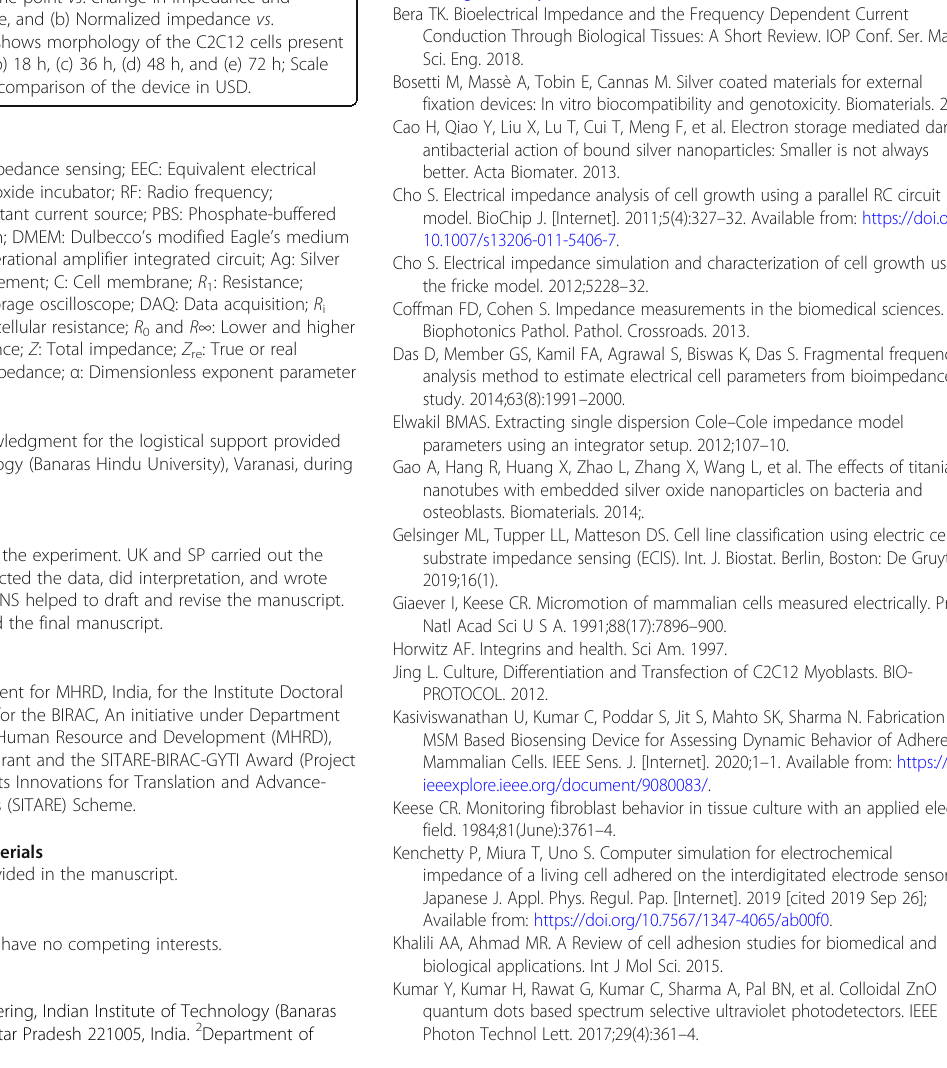
Additional file 1: Figure S1. Calibration graph using different R 1 values. Figure S2. shows the experimental data and its fitting. Figure S3. shows the flowchart for calculating the impedance; (a) Transmitting end, and (b) Receiving end. Figure S4. shows the rate of proliferation with respect to impedance (a) Time point vs . change in impedance and average cell count per image, and (b) Normalized impedance vs . frequency plot. Figure S5. shows morphology of the C2C12 cells present near the electrode (a) 6 h, (b) 18 h, (c) 36 h, (d) 48 h, and (e) 72 h; Scale bar: 20 μ m. Table S1. Cost comparison of the device in